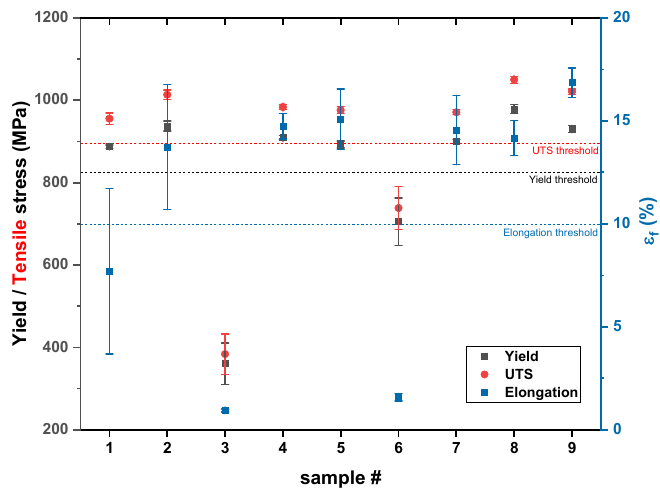
Figure 5. Mean values and standard deviations of yield strength, ultimate tensile strength, and elongation. The horizontal dashed lines are the yield (black), UTS (red), and elongation (blue) thresholds according to ASTM F2924 [54].